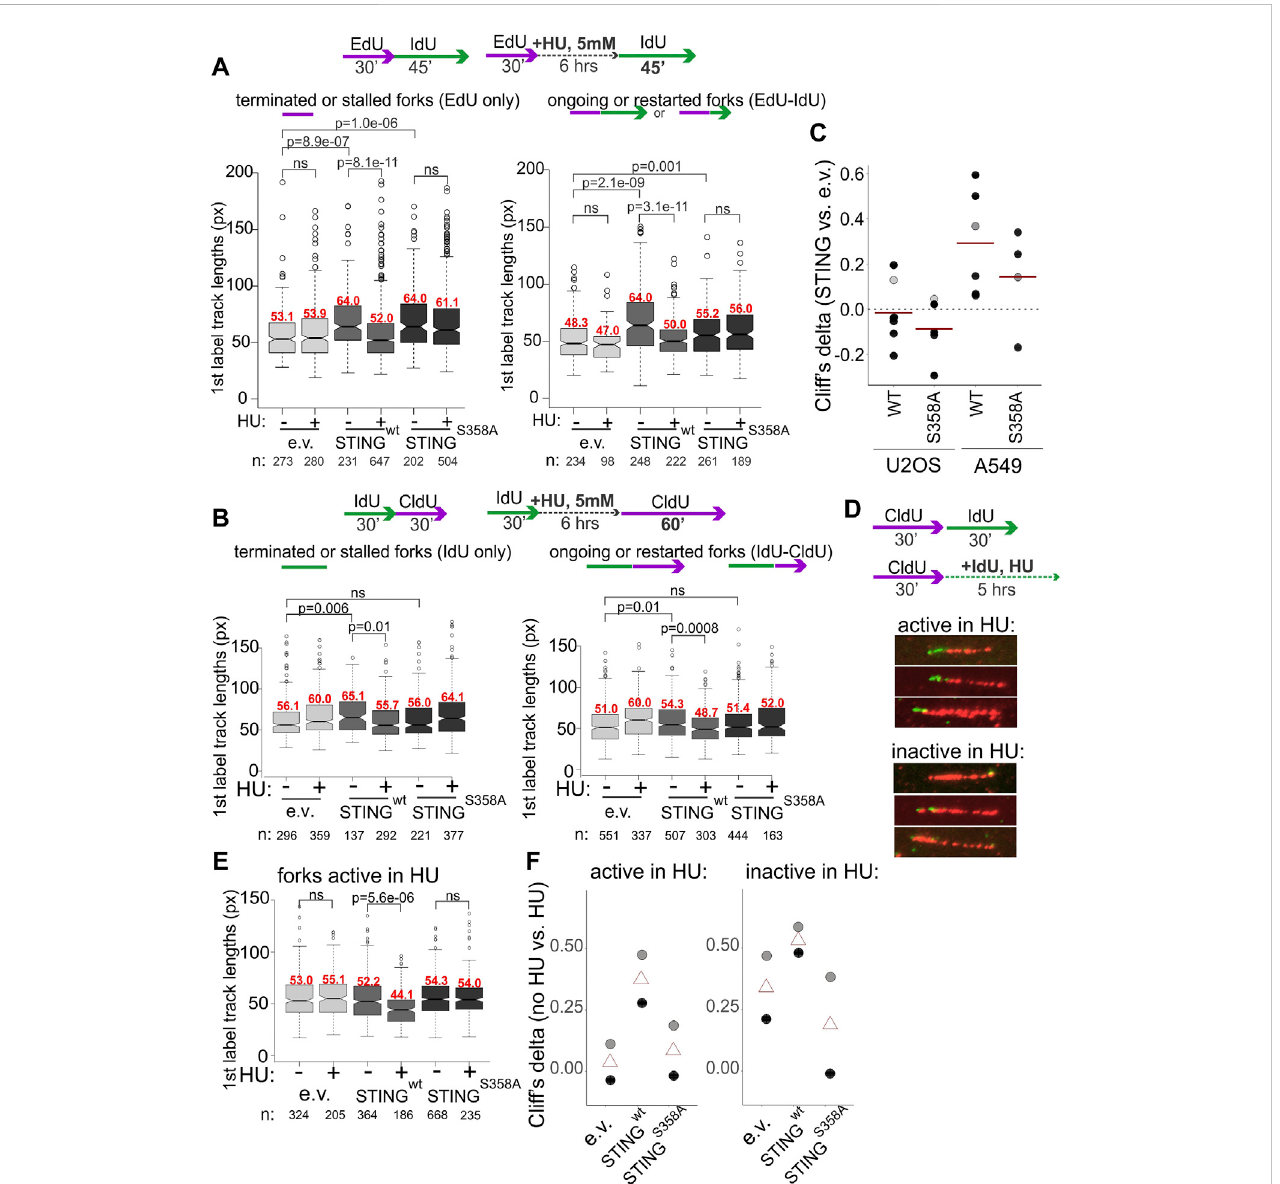
FIGURE 5 Activation of STING is important for its effect on degradation of nascent DNA. (A,B) Experimental design and boxplots of fi rst label (IdU) track length distributions in terminated/stalled forks (left panels), or ongoing/restarted forks (right panels) in the A549 cells (A) and U2OS cells (B) expressing the indicated transgenes. The results represent two independent experiments each. p values are determined in KS tests. Median values of distributions are shown in red above the boxes. (C) Cliff ’ s delta values for the size of differences in unperturbed fork progression between empty vector and STING-expressing cells were calculated from six independent experiments each performed in U2OS and A549 cells. First label track lengths in ongoing forks were used for the calculation, and positive values correspond to longer tracks/faster fork progression in STING-expressing cells compared to the empty vector controls. Red lines are means. Gray circles identify the Cliff ’ s delta values derived from the experiments shown in (A,B) . (D) A labeling scheme and examples of forks that incorporate trace IdU (are “ active ” ) or do not incorporate any IdU (are “ inactive ” ) in the presence of 5 mM HU. (E) A boxplot of fi rst label (CldU) track length distributions in the “ active in HU ” forks in U2OS expressing the indicated transgenes. The results represent two independent experiments. p values were determinedinKStests. (F) Differencesbetween fi rstlabel(CldU)tracklengthdistributionsinuntreatedvs.HU-treatedcellswiththeindicatedtransgeneswere quanti fi ed by calculating the respective Cliff ’ s delta values. Positive values correspond to longer tracks in untreated cells compared to HU-treated cells. Cliff ’ s delta values from two independent experiments (black and gray circles respectively) and their averages (triangles) were